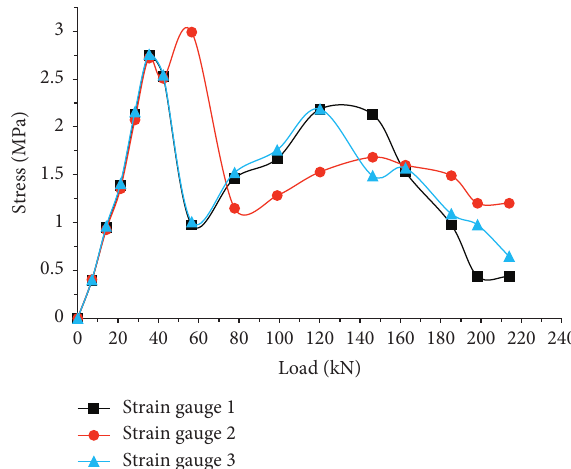
Figure 13: Stress/load curves at different measuring points in the tensile zone of the concrete specimen along the short-span